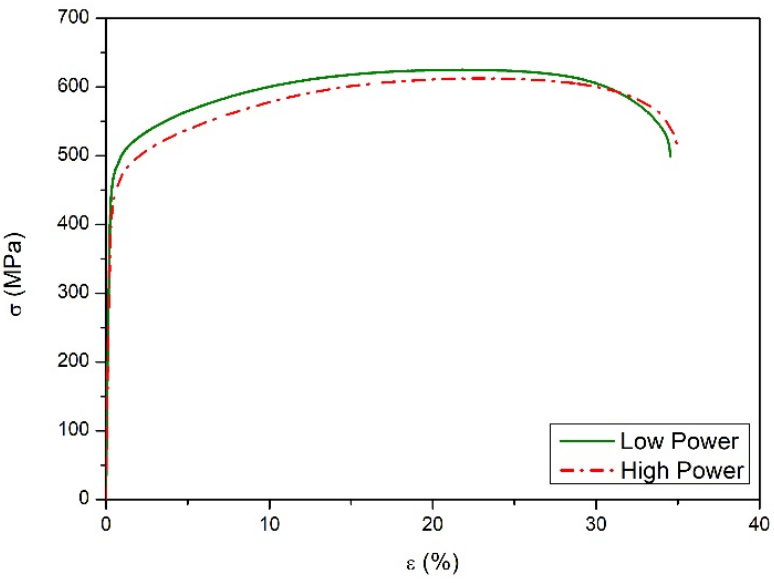
Figure 6. Representative tensile curves of DED 316L samples built with high power and low power parameters. Table 3. Tensile properties of DED 316L samples compared with literature data.